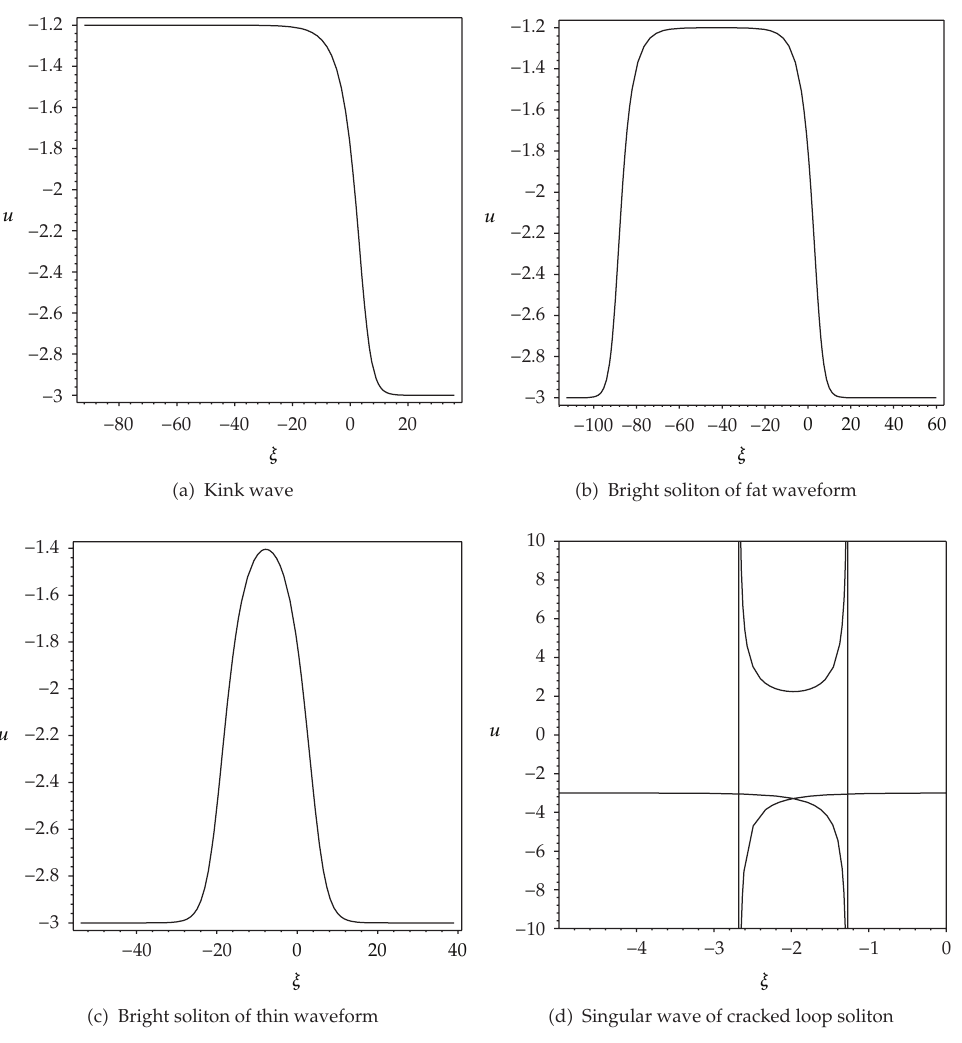
Figure 2: The profiles of multiwaveform of (cid:2) 3.7 (cid:3) for the given parameters and di ff erent ε -values: (cid:2) a (cid:3) ε (cid:7) 1 . 2; (cid:2) b (cid:3) ε (cid:7) 1 . 20000001; (cid:2) c (cid:3) ε (cid:7) 1 . 22; (cid:2) d (cid:3) ε (cid:7) 2 . 4